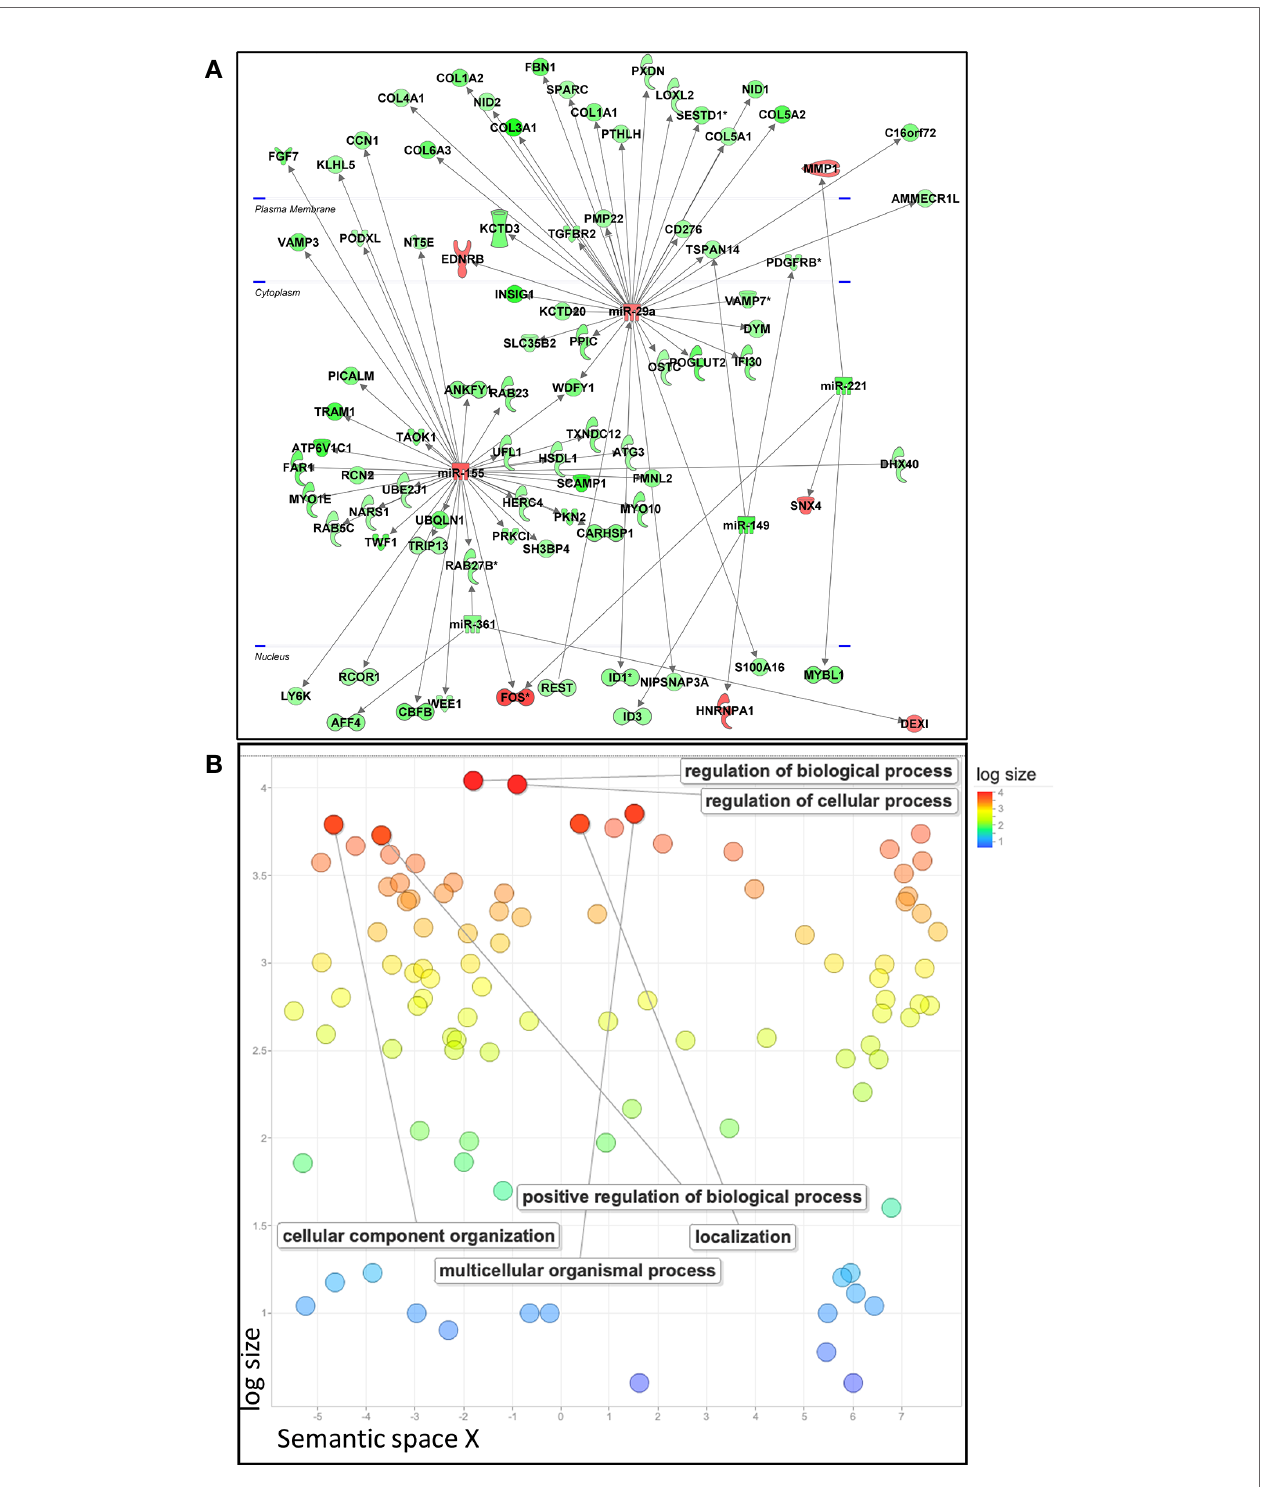
FIGURE 2 | Analysis of predicted miRNA - mRNA interactions by IPA ’ s miRNA Target Filter . (A) The resultant differentially expressed genes by over-expression of miR-155, miR-146a and miR-29a and down-expression of miR-149 and miR-361, re fl ecting the immunosuppressive conditions of MSCs, were uploaded on the IPA software to identify putative targets and signi fi cant biological functions. (B) Gene Ontology scatterplot generated with REVIGO for all the GO terms associated with modulated genes re fl ecting the immunosuppressive conditions of pMSCs and identi fi ed using STRING database. Settings used for REVIGO program were as follow: Homo sapiens database, SimRel as semantic similarity measure, the allowed similarity was medium (0.7) between the enriched GO